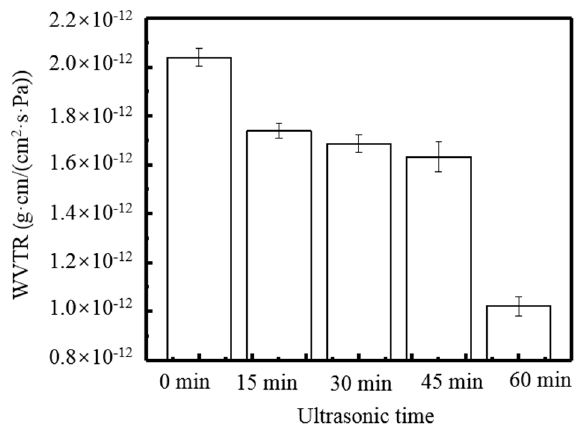
Figure 7. E ff ect of time of ultrasound treatment of film solution on Figure 7. Effect of time of ultrasound treatment of film solution on WVTR.